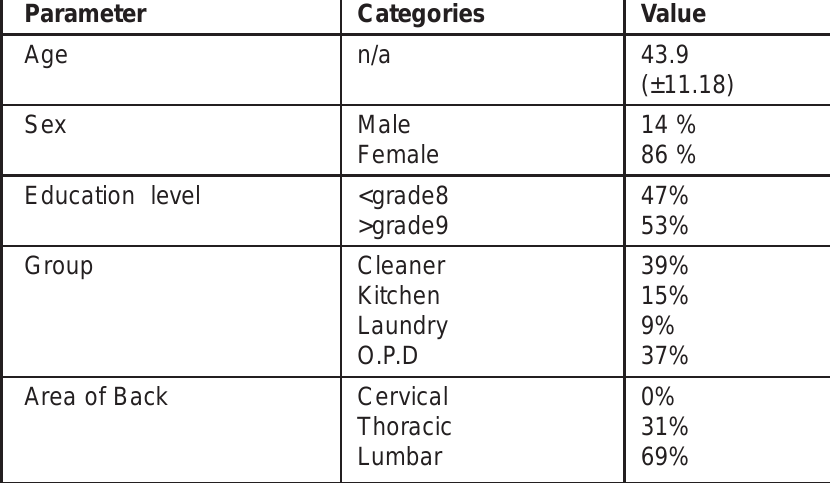
Table 1: Demographic data of subjects (n = 100).